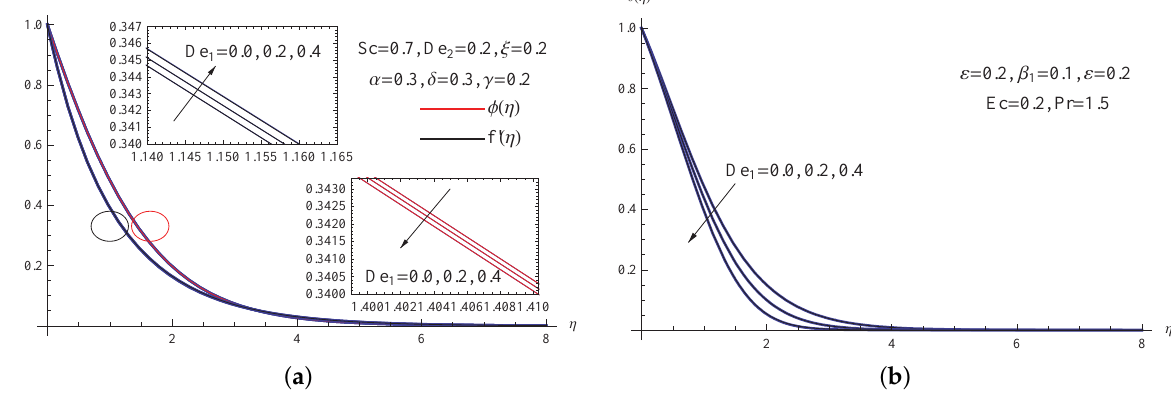
Figure 5. ( a ) f (cid:48) ( η ) and φ ( η ) for picked ε . ( b ) θ ( η ) for picked ε . The actions of the velocity profiles f (cid:48) ( η ) , the temperature profiles θ ( η ) and the concen- tration fields φ ( η ) for escalating values of the thermal Deborah number De 1 are depicted in Figure 6. The velocity distribution f (cid:48) ( η ) barely rises for the larger De 1 parameter, while the concentration profiles φ ( η ) are somewhat marginally decreased with the expansion of the same parameter De 1 . In addition, expanded values of the same parameter De 1 lower both the temperature profiles and the thermal boundary thickness. In terms of physics, when the thermal Deborah number rises, the relaxation time for the heat flux also increases, mean- ing that both the thermal boundary layer thickness and the mechanism of heat diffusion become low.